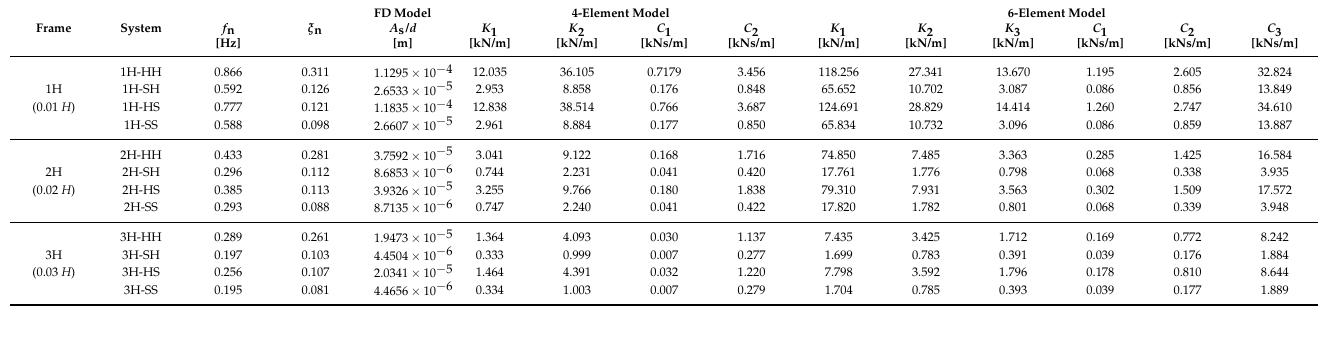
Table 2. Parameters of the FD model, 4-element model, and 6-element model.